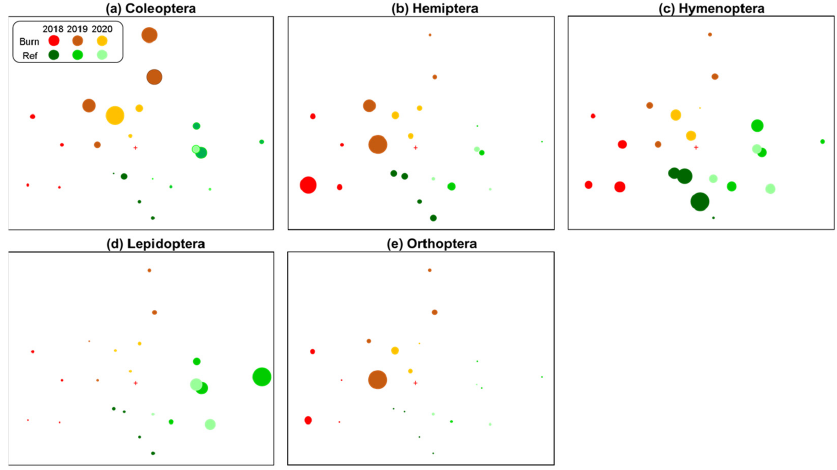
Figure 7. NMDS ordination results for non-dipteran insect Orders in burn and reference study sites. Panels ( a – e ) show results for each Insect order; ( a ) Coleoptera ( b ) Hemiptera, ( c ) Hymenoptera, ( d ) Lepidoptera and ( e ) Orthoptera. Symbol size is scaled by percent abundance within each sample.